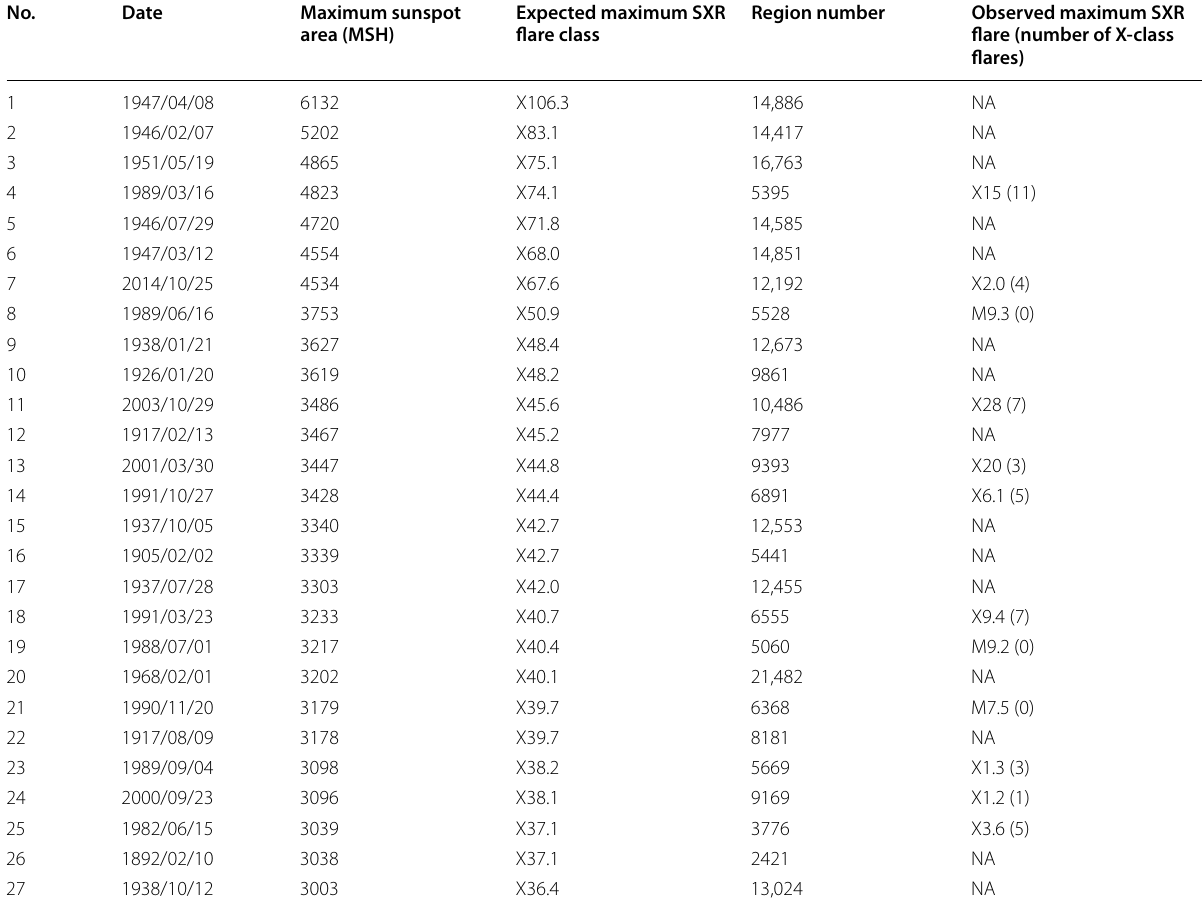
Table 2 Sunspot groups with maximum area of more than 3000 MSH and expected and observed maximum SXR flare class between 1879 and 2016 in the MA20 catalogue